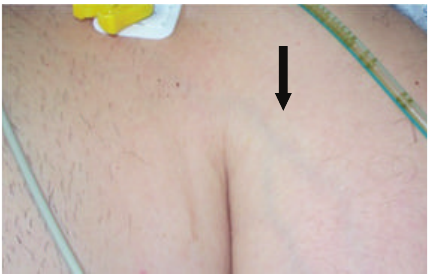
Figure 1: Physical examination: upper left limb edema with visible collateral veins above left clavicle and in the left arm.